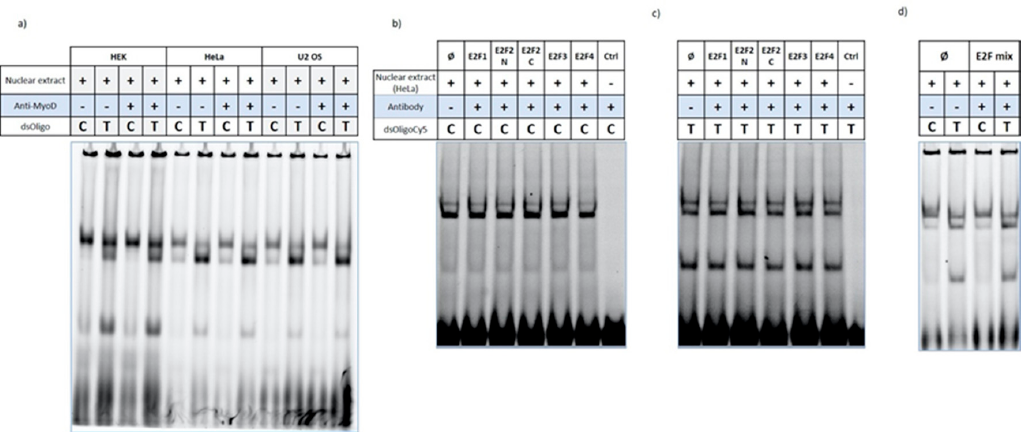
Figure 6. CLSPN c.-68C>T variant might alter transcription factor binding stoichiometry. Competition assays were performed with labelled oligonucleotides (dsOligoCy5) containing the C or T allele corresponding to CLSPN c.-68C>T. Where indicated (+) cold competitor probes containing either C or T were added to the reaction in a 0.2-, 0.5-, 1-, 2- or 5-fold excess, and their effect compared to the null reaction (Ø lane—no competitor added). The last lane of each assay corresponds to a reaction in which only the labelled oligonucleotide was added (ctrl). A representative assay for HEK293 cells is shown. The assay was also performed for HeLa and U2 OS cell lines (Figures S4 and S5). The assays were repeated at least three times for each cell line. Detailed information can be found at Figure S6.